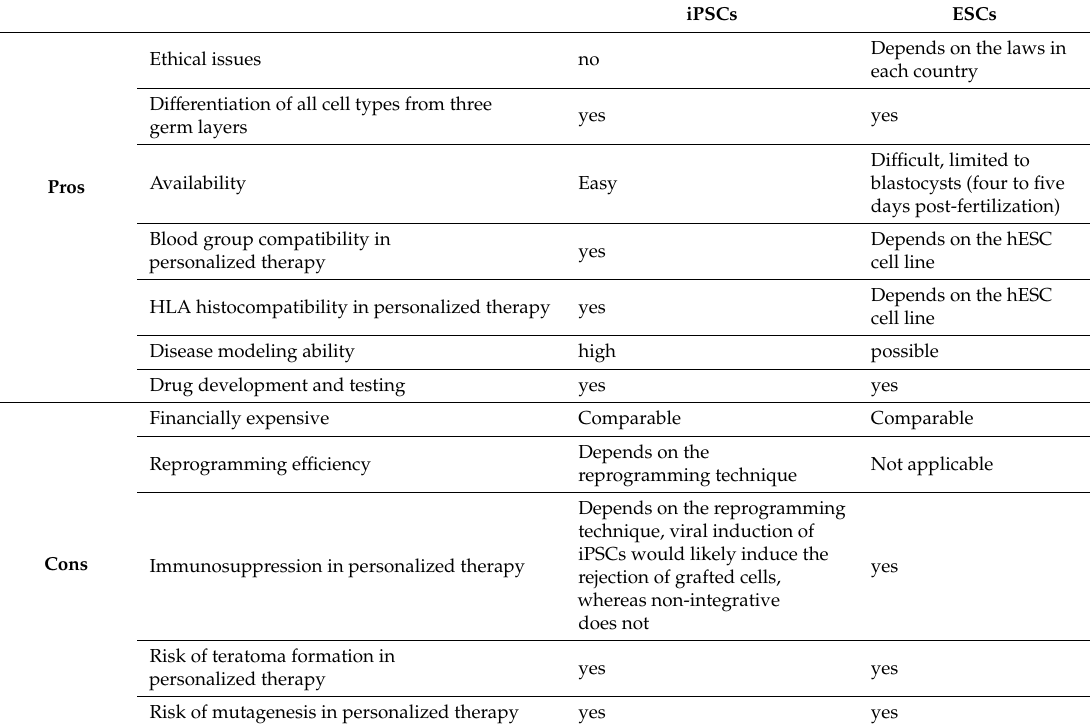
Table 2. Comparison of the main advantages and disadvantages of human iPSCs and ESCs [4,38,39]. iPSCs